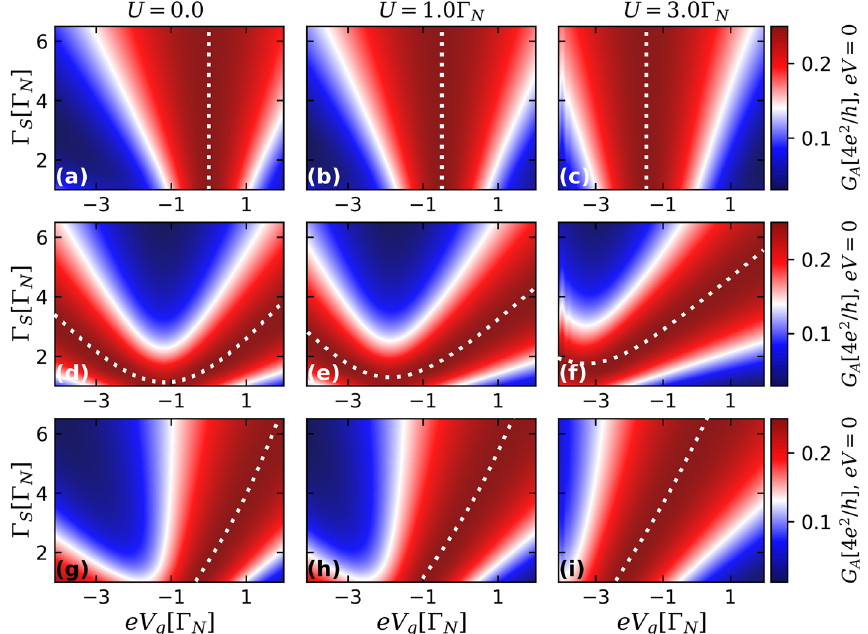
Figure 3. Color scale plots of Andreev conductance [Eq. (5)] at zero-bias as a function of the QD-S hybridization strength Ŵ S and the QD gate-voltage eV g for the case of nonoverlapping ( ε M 0 ), corresponding to ideal topologically protected situation, considering several values nonlocal MBSs ( (cid:31) R σ = of Coulomb correlation strength U . Upper panels correspond to the spin-independent QD-TSC coupling (cid:31) 0.5 , (cid:31) ( p ), while middle and lower panels depict the fully-spin polarized ( p L L = ↑ = ↓ (cid:31) 0 ) and the case of intermediate polarization ( p L ↓ = correspond to isoconductance lines, defined by the condition that the conductance reaches its maximal value, 0 ) G A ( eV e 2 / h = =